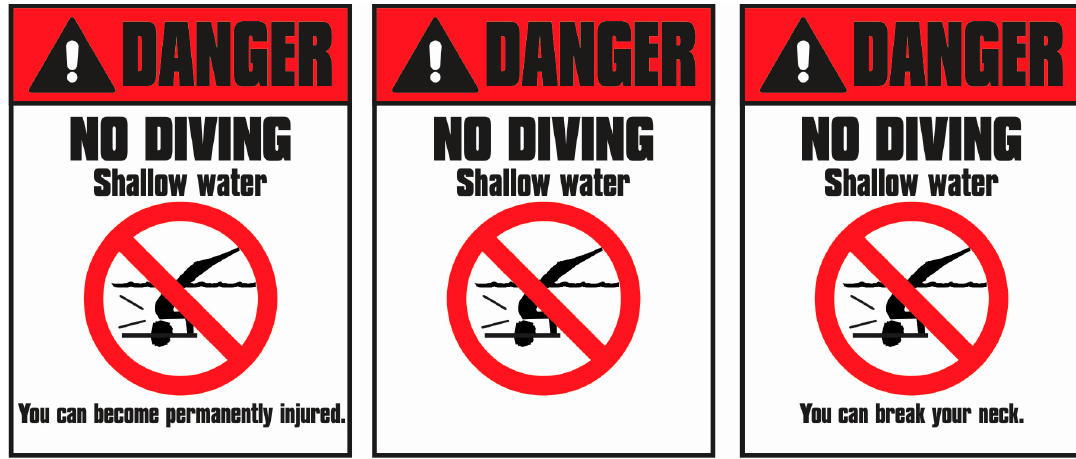
Figure 2. The warning signs shown to children individually to assess their understanding of the image ( center ); the phrase “permanently injured” ( left ); and the phrase “break your neck” ( right